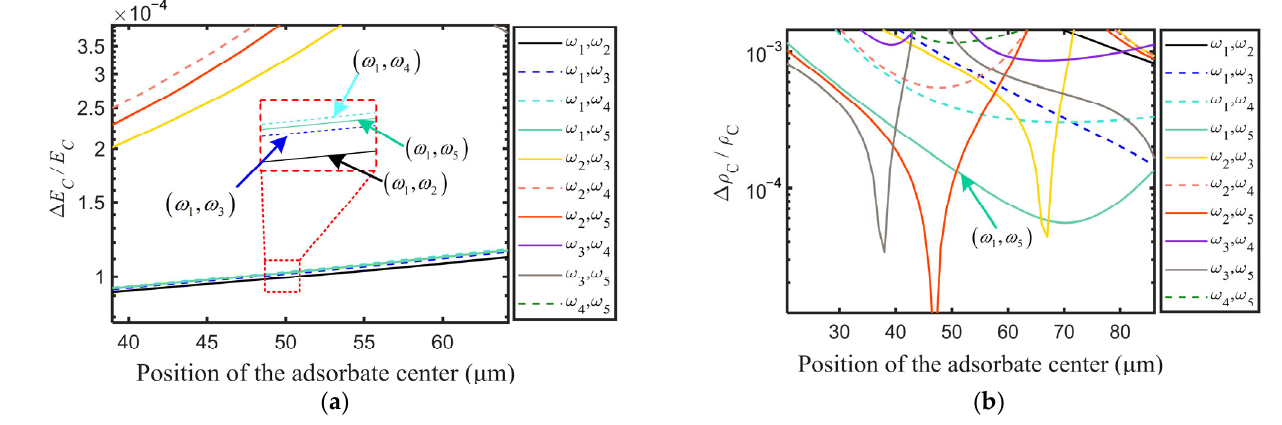
Figure 9. The partial zoom of Figure 4 contains the curves of different frequency pairs of the adsorbate locating at 50 μ m from the fixed end of the resonator. ( a ) Young’s modulus errors, ( b ) Density errors. Finally, ( ω 1 , ω 2 ) was picked out for the Young’s modulus measurement and ( ω 1 , ω 5 ) was picked out for the density measurement of the adsorbate. The E C was calculated as 1.309 GPa, with an error of 3.75% compared with the ideal value of 1.36 GPa. Furthermore, the ρ C was calculated as 760.5 kg/m 3 , with an error of − 1.94% compared with the ideal density value of 746 kg/m 3 . The selected frequency pairs and the relative Young’s modulus and density result are shown in Figure